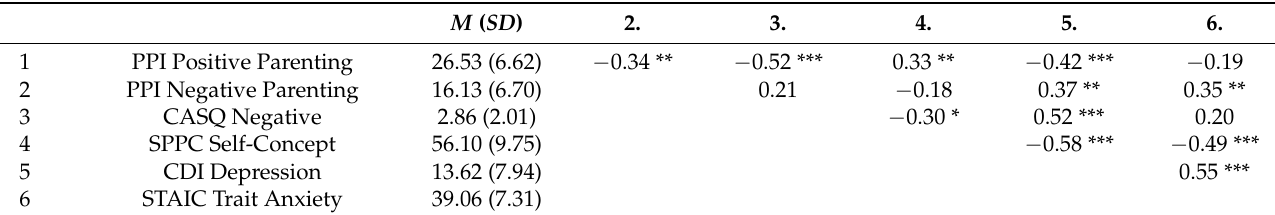
Table 1. Means, standard deviations, and intercorrelations across